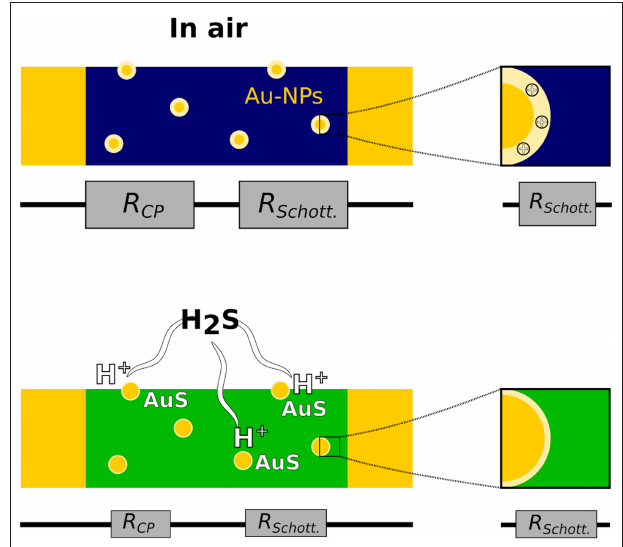
FIGURE 2 | Mechanisms of H 2 S detection by CPs hybridized with metallic nanoparticles (Au-NPs). R CP and R Schott represent the resistance contribution of the polymer and depletion layer (in pale yellow) at the interface with the metal (Schottky junction), respectively. Those resistances tend to decrease in contact with H 2 S